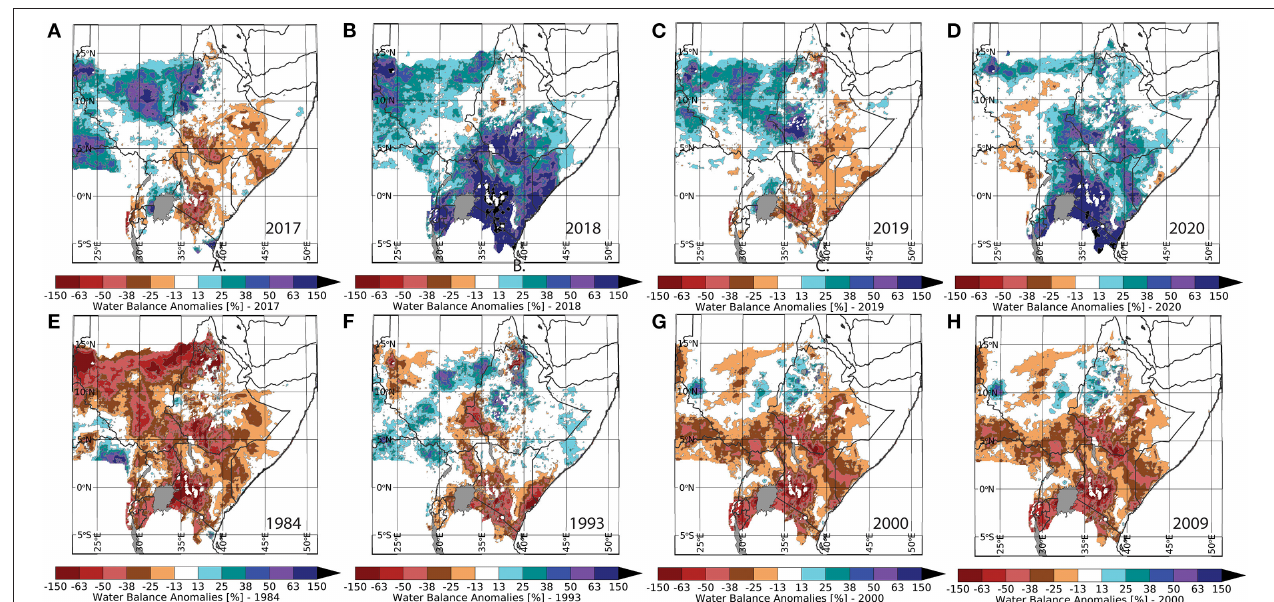
FIGURE 3 | Seasonal PWB maps, expressed as percent anomalies from the long-term average, for the four most recent years ( A 2017, B 2018, C 2019, D 2020) and four extremely dry prior years ( E 1984, F 1993, G 2000, H 2009).